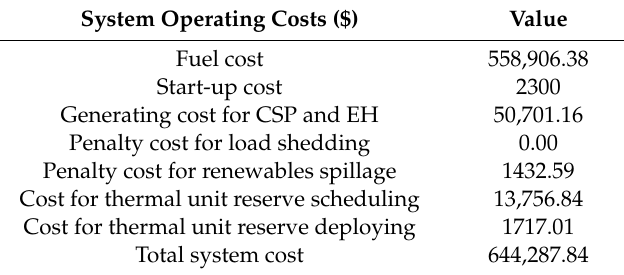
Table 4. Results for system costs with CSP and EH